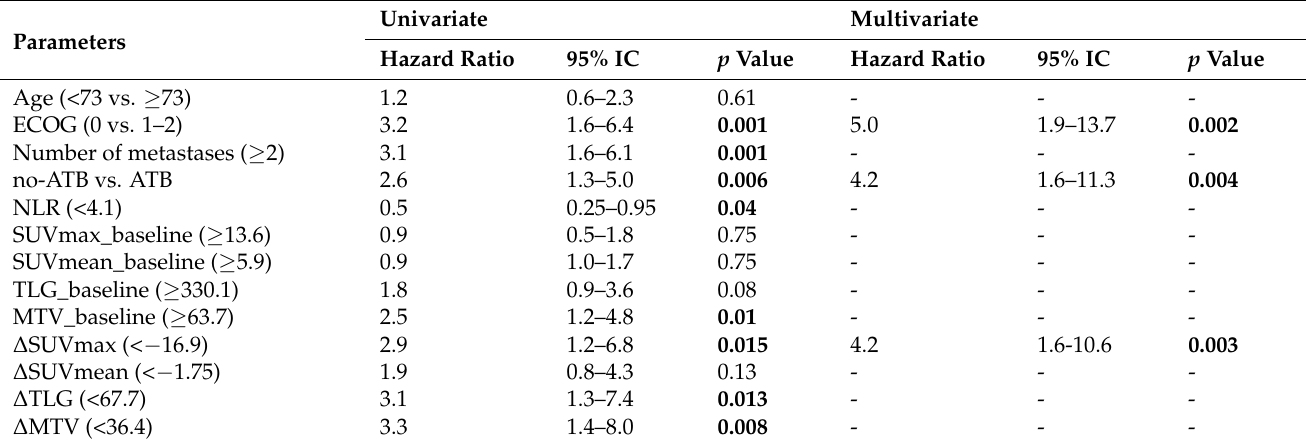
Table 3. Uni- and multivariate analysis for progression-free survival (PFS).